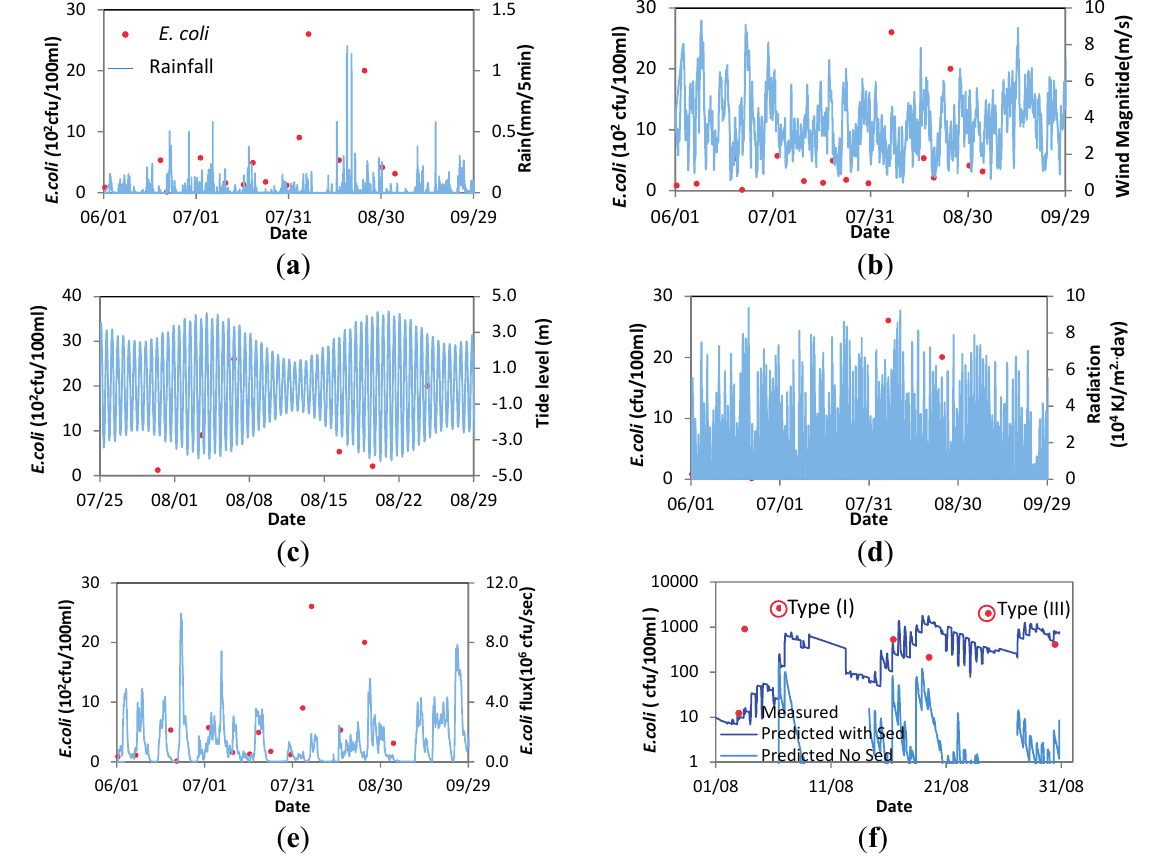
Figure 6. Example site (No. 41800) for recognising event types at bathing water site (See Figure 1 for location) ( a ) E. coli and Rainfall; ( b ) E. coli and wind magnitude; ( c ) E. coli and tidal level process; ( d ) E. coli and riverine Radiation; ( e ) E. coli and riverine E . coli flux input; ( f ) E. coli calculated with and without sediment